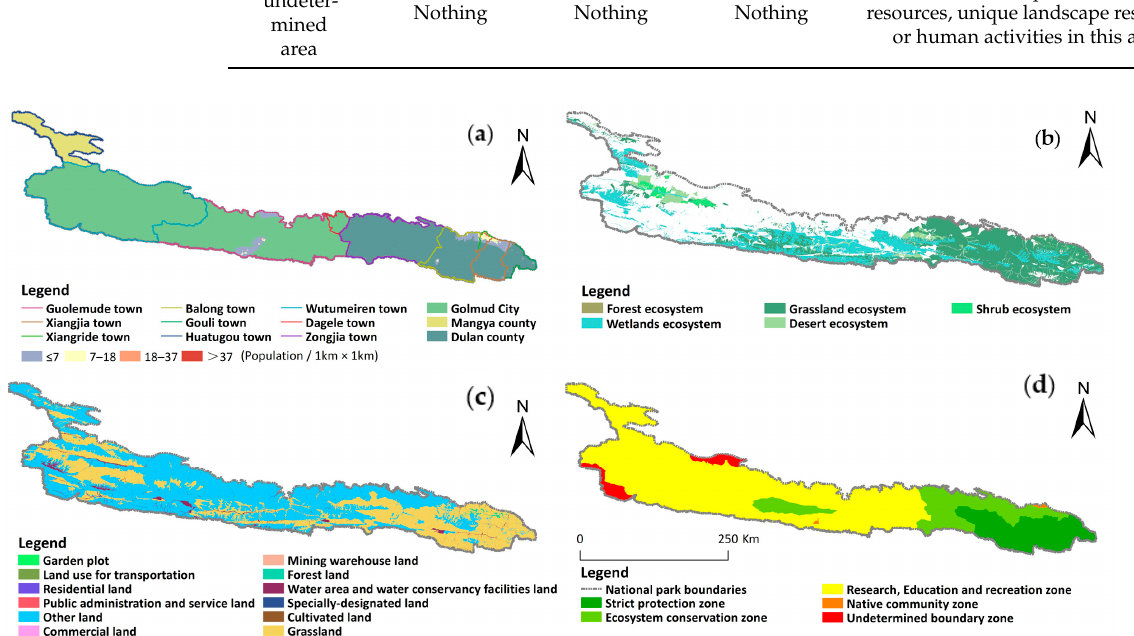
Figure 2. Functional zone map of the proposed Kunlun Mountain National Park. ( a ) Population dis- tribution and administrative zoning map; ( b ) Ecosystem map; ( c ) Land use status map; ( d ) Functional zoning